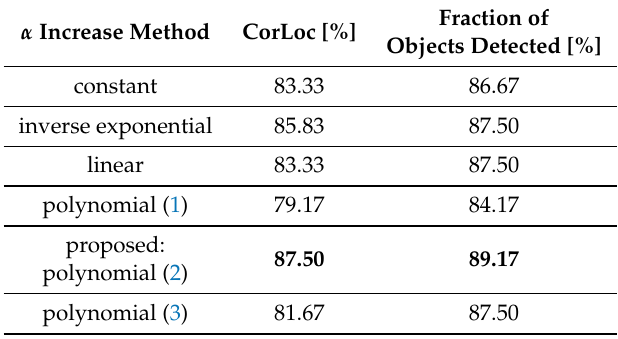
Table 5. Results showing variants of controled weight α with the Stanford Dog dataset.